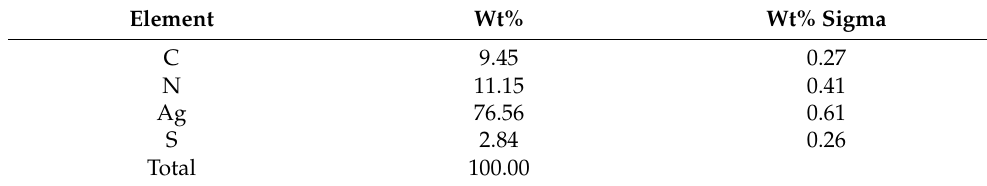
Table 1. Mass distribution of elements in EDS.